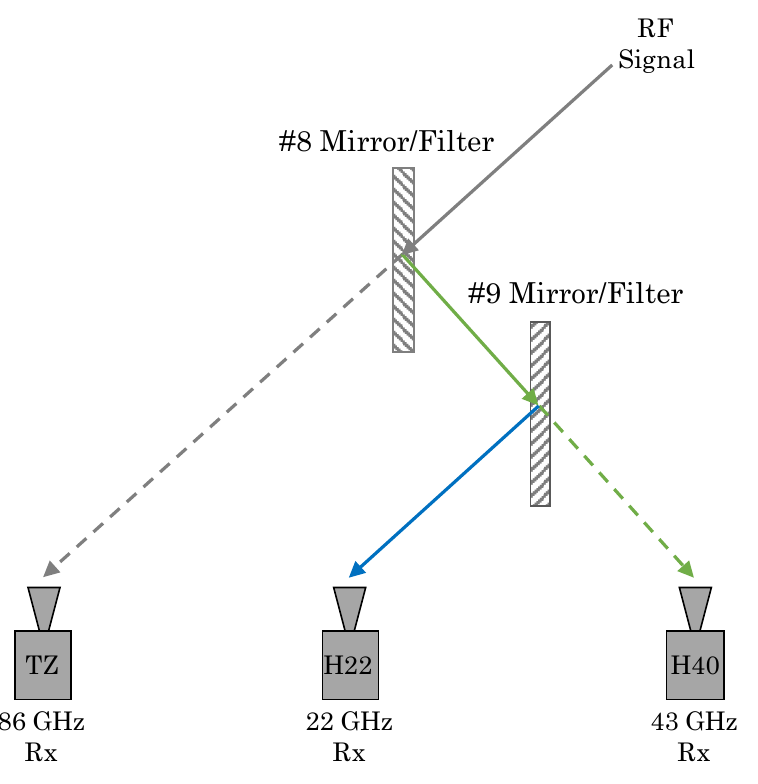
Figure 1. Schematic diagram of triple-band optics in the NRO45 developed by HINOTORI. The RF signal comes from the direction labeled “RF